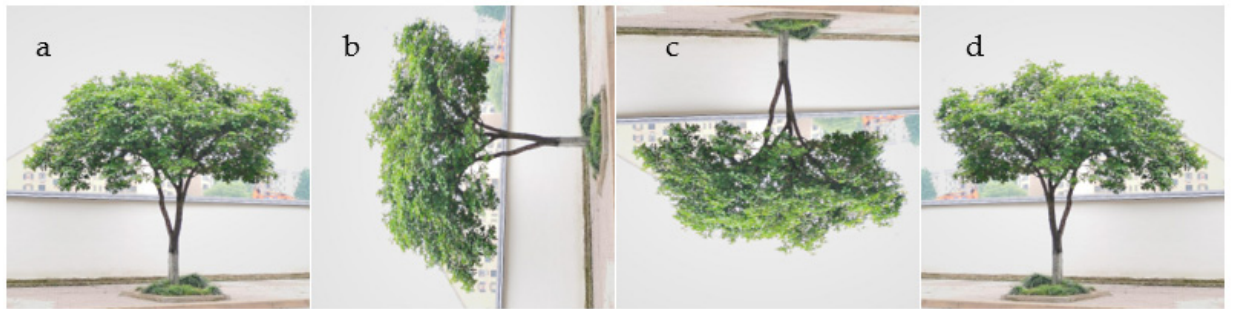
Figure 6. Data augmentation. ( a ) Original image. ( b ) Rotated image. ( c ) Flipped vertically. ( d ) Flipped horizontally.